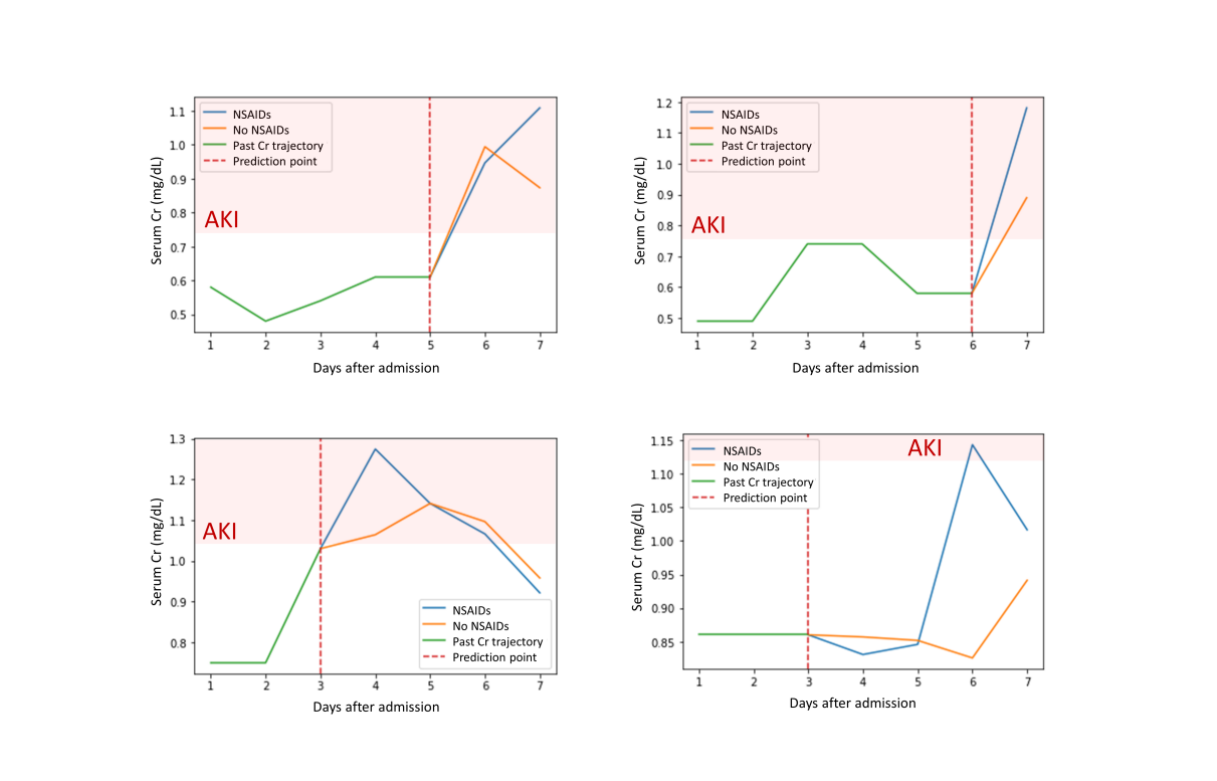
Figure 4. Individual interpretation with individual conditional expectations (green lines: the past Cr values; blue lines: predicted Cr values on certain nephrotoxic drugs; orange lines: predicted Cr value when nephrotoxic drugs are discontinued; and dotted red lines: prediction point). Modified drugs are NSAIDs in these 4 cases. AKI: acute kidney injury; Cr: creatinine; NSAIDs: nonsteroidal anti-inflammatory